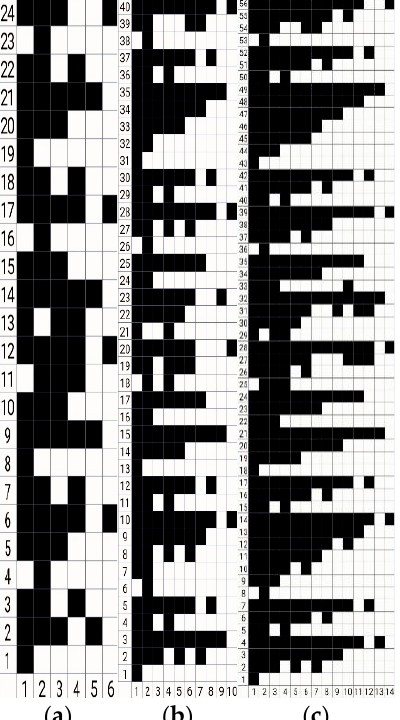
Table 1. Weaving parameters of 3-D honeycomb woven fabrics.